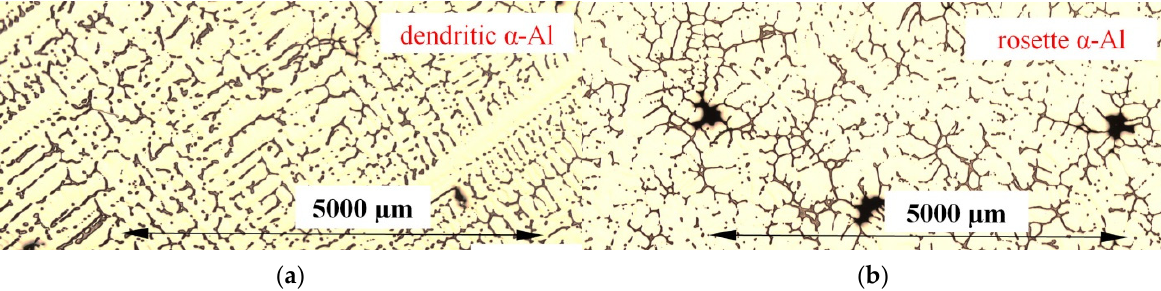
Figure 2. Microstructures of the AlCu4 specimen solidified: ( a ) without and ( b ) with electromagnetic stirring. LOM, magnification 50 × .